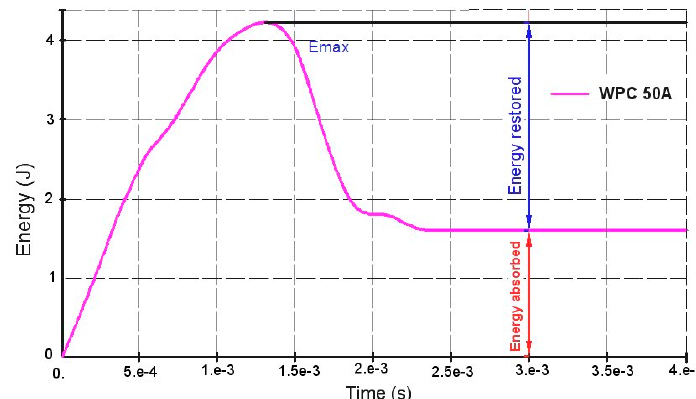
Figure 6. Energy balance during the impact.